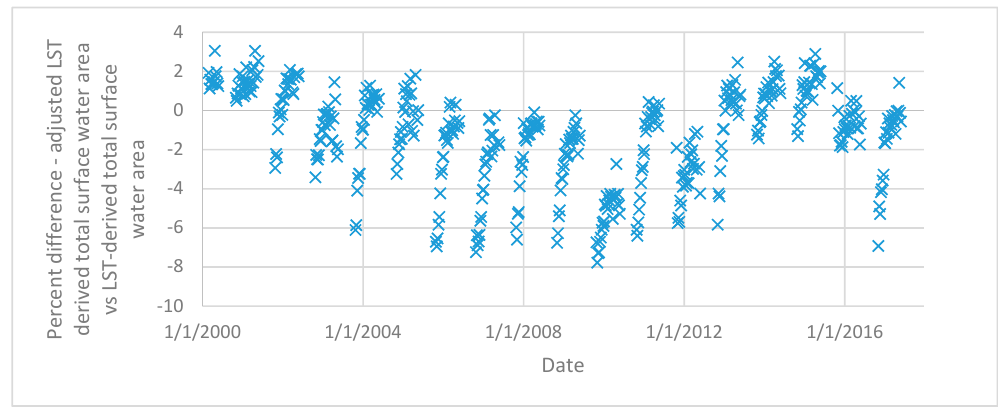
Figure 10. Percent difference between adjusted MODIS Land Surface Temperature (LST)-derived Lake Chad total surface water area and initial total surface water area. The results retain a strong seasonal signal from the source LST